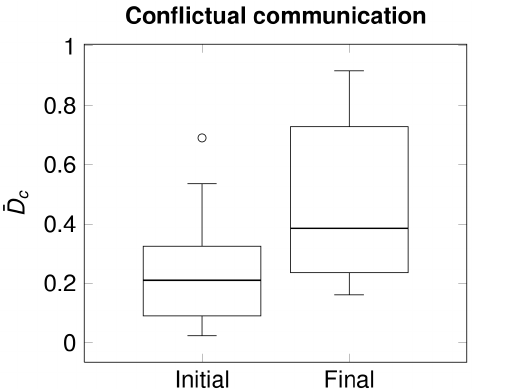
Figure 1. Normalized fraction of duration for the conflictual communications during initial and final sessions of the BSFT. (cid:2) DD c : normalized fraction of duration for the conflictual communications.